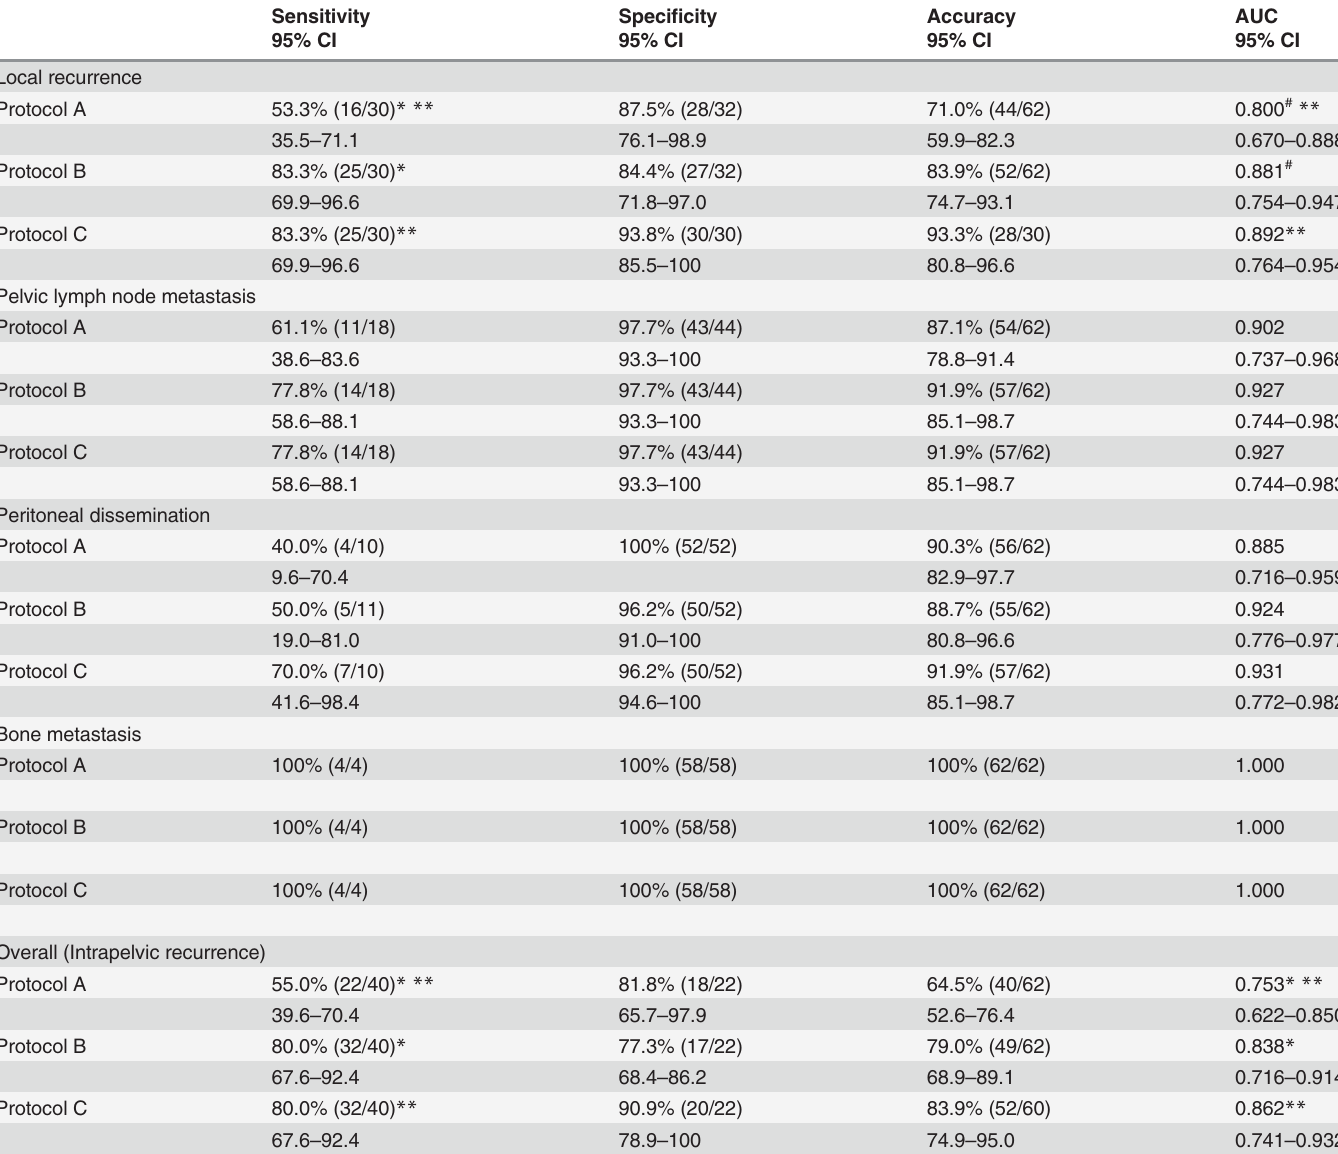
Table 1. Comparison of three protocols for diagnosing intra-pelvic recurrence on a per patient